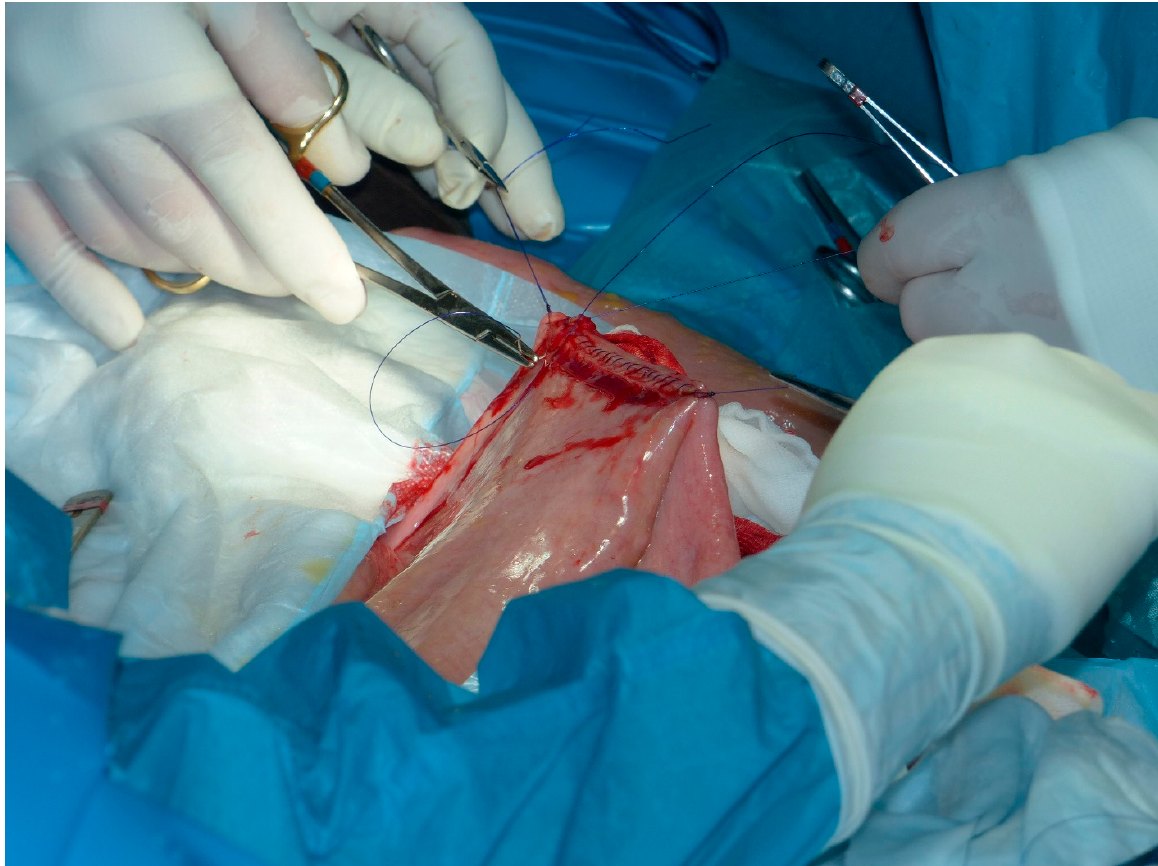
Figure 2. Continuous simple suture comprising mucosa and submucosa of jejunum and cecum applied to complete the underside of the anastomosis.